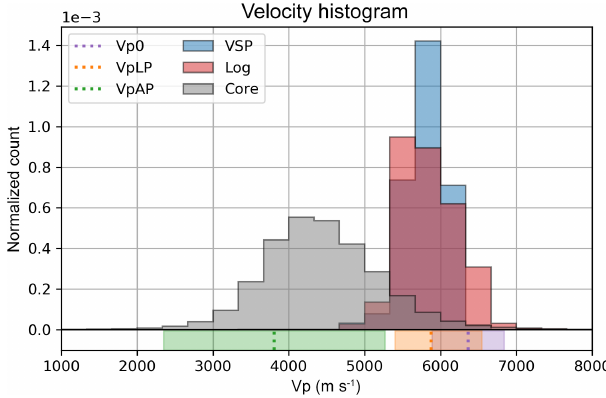
Figure 10. Distribution of P-wave velocities derived from labo- ratory samples (Vp0, VpLP, VpAp), core measurements (Core), downhole logging (Log), and borehole seismic (VSP). The sample velocities are displayed below the histograms indicating the mean and standard deviation of the 16 laboratory core